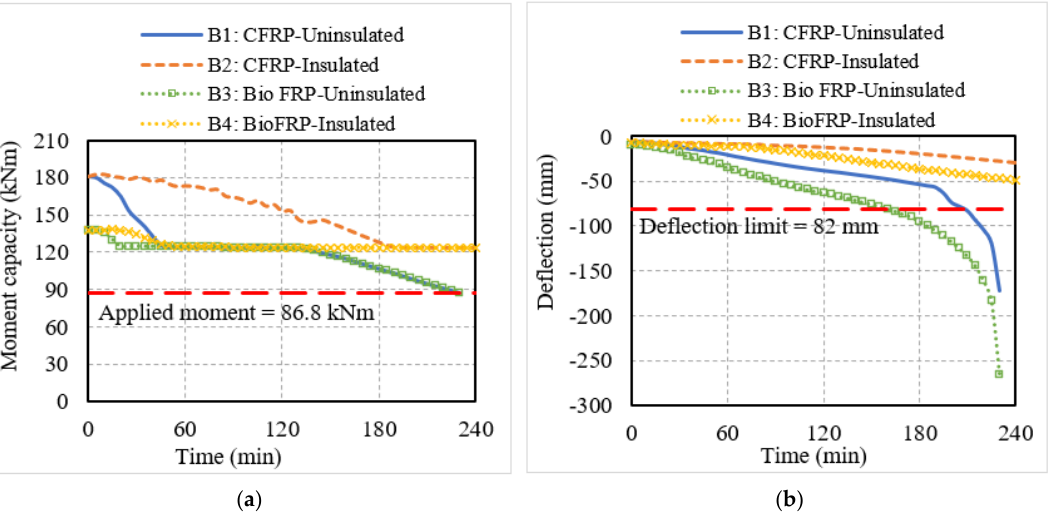
Figure 7. Structural response of T-beams strengthened with conventional or bio-based NSM FRP reinforcement. ( a ) Moment capacity; ( b ) mid-span deflection.